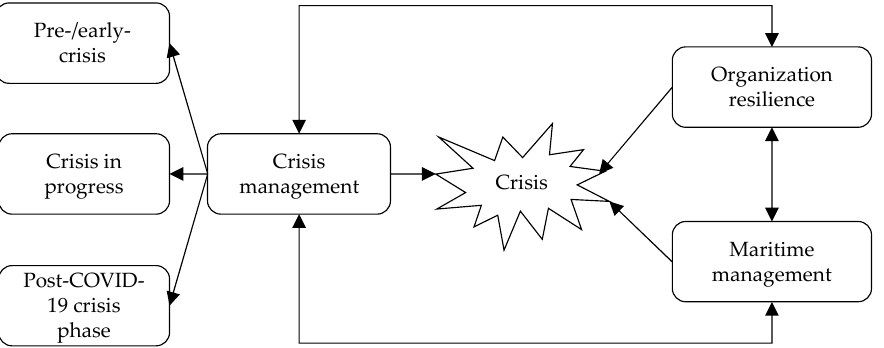
Figure 2. Integrated theoretical framework.